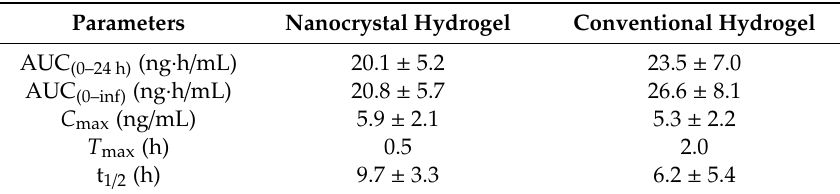
Figure 5. Plasma concentration–time profiles of MTK following single administration of the nanocrystal hydrogel or conventional hydrogel on the dorsal skin of healthy rats at a dose of 15 mg / kg. Each point represents mean ± standard error ( n = 6). Table 3. Pharmacokinetic parameters of MTK following dorsal application of the nanocrystal hydrogel or conventional hydrogel in rats.